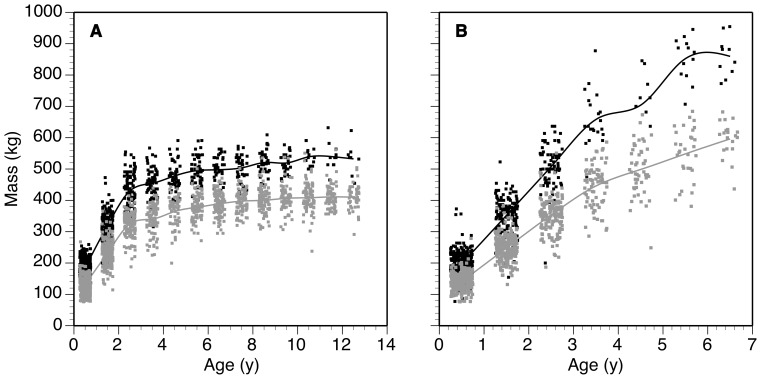
Growth curves for bison.Shown are female (a) and male (b) bison from Wichita Mountains, Oklahoma (grey) and Ordway Prairie, South Dakota (black). Unconstrained spline fit to mean mass of each age cohort for each site shown. Ages are jittered to show point density.